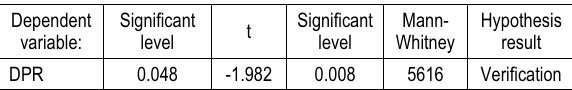
Table 3. Results of t-test and Mann-Whitney tests in